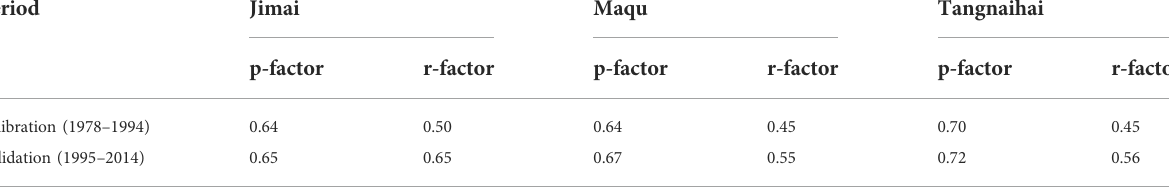
TABLE 5 Uncertainty of runoff simulation at three hydrological